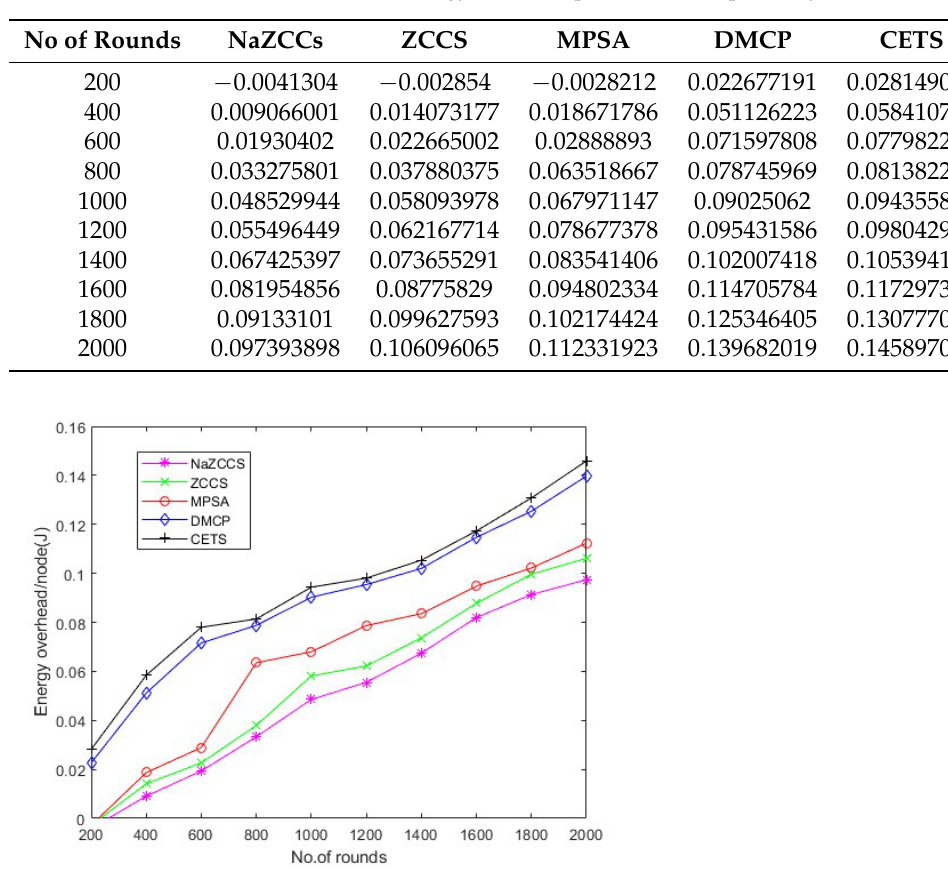
Table 13. CETS versus other models on energy overhead per round at hop density 0.3.